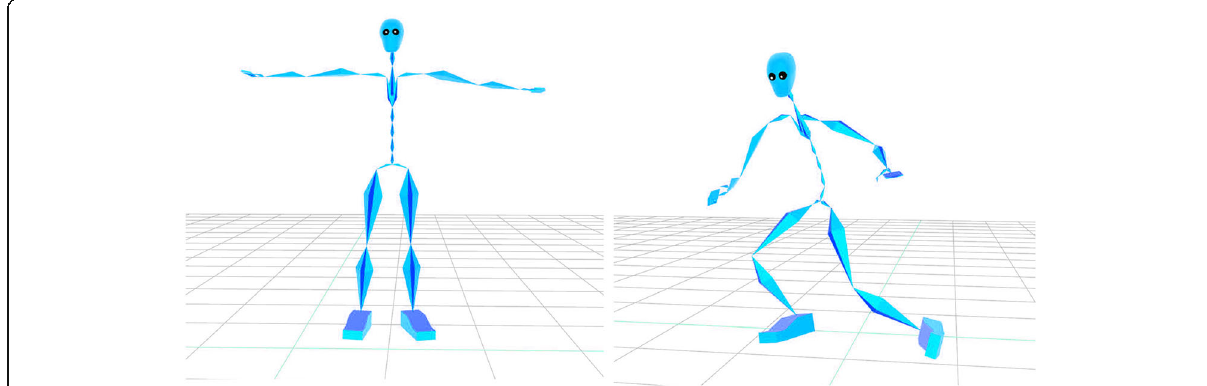
Fig. 3 Example of a poseable skeleton model. “ Bones ” of a pre-specified length are connected at joints, and rotation of the bones around these joints allows the skeleton to be posed. The skeleton model is commonly fit to both marker-based motion capture data